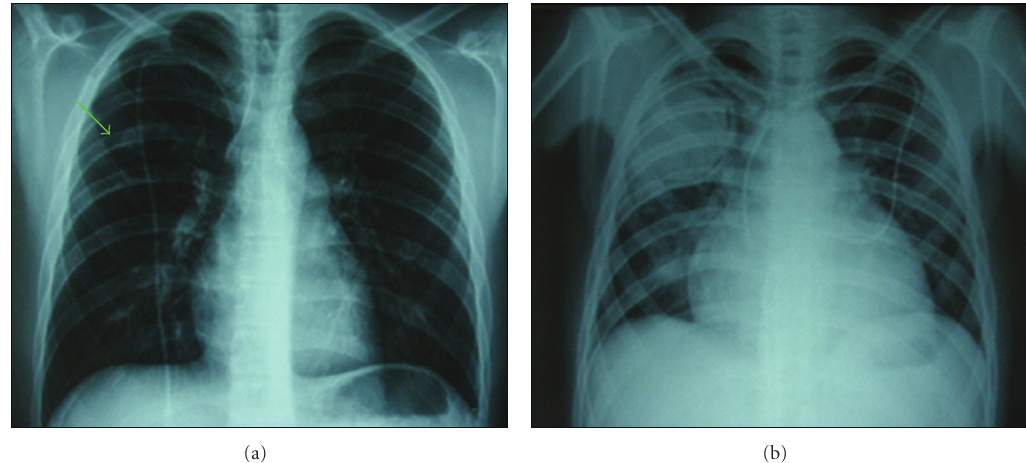
Figure 1: Thoracic X-ray: (a) on day 176, it could be observed a small pulmonary node behind the fifth right thoracic rib (arrow); (b) 3 months, later the pulmonary node was much larger and became cavitated.